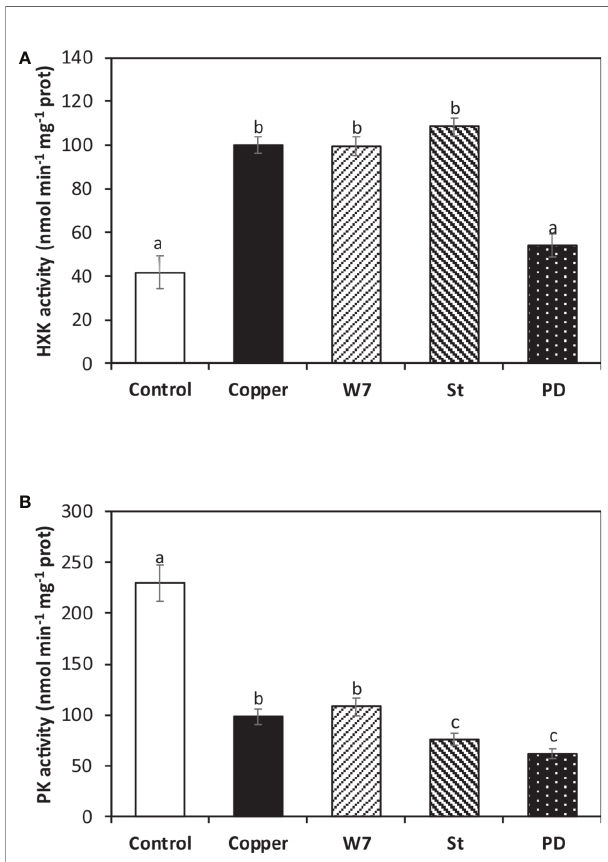
FIGURE 2 | Activities of L-galactone 1,4 lactone dehydrogenase ( A , L- GLDH) and glucose 6-P dehydrogenase ( B , G6PDH) in the alga cultivated in seawater without copper addition (open circles) and with 10 µM copper (black circles) for 0 to 10 days. Enzyme activities are expressed in nanomoles per minute per milligram of protein extract, and time in days. Symbols represent mean values of three independent experiments. Different letters indicate signi fi cant differences among mean values (±SD) ( P < 0.05).